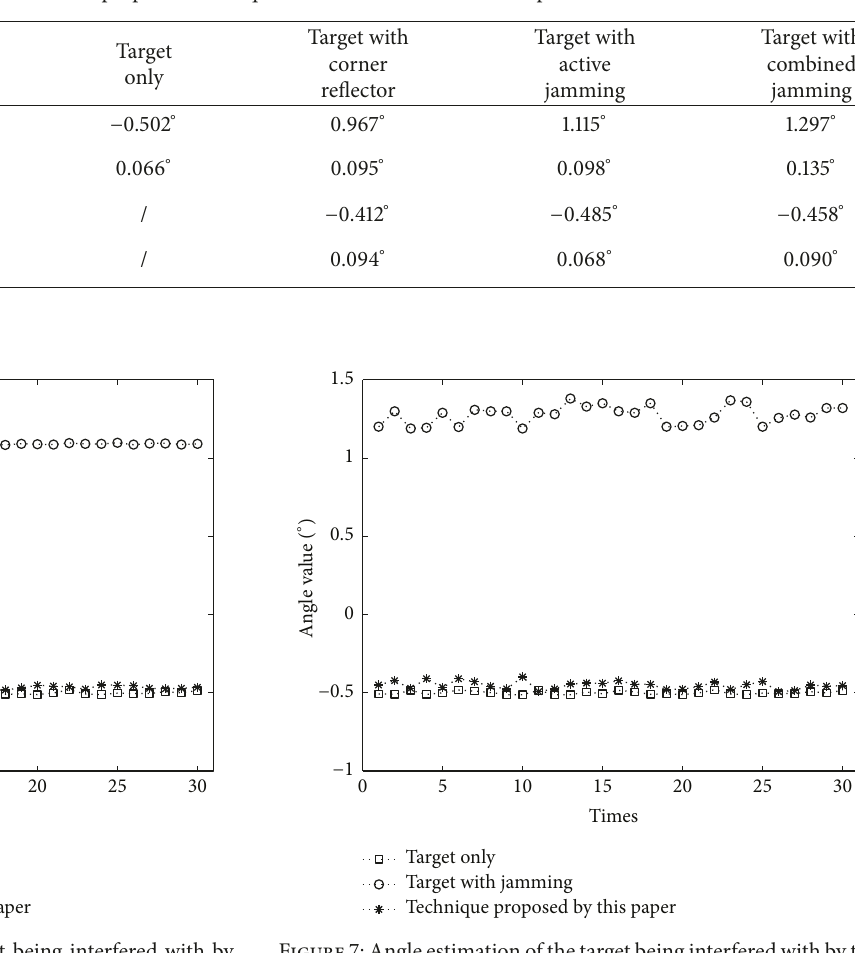
Table 1: Comparison of the proposed technique with the conventional monopulse method.